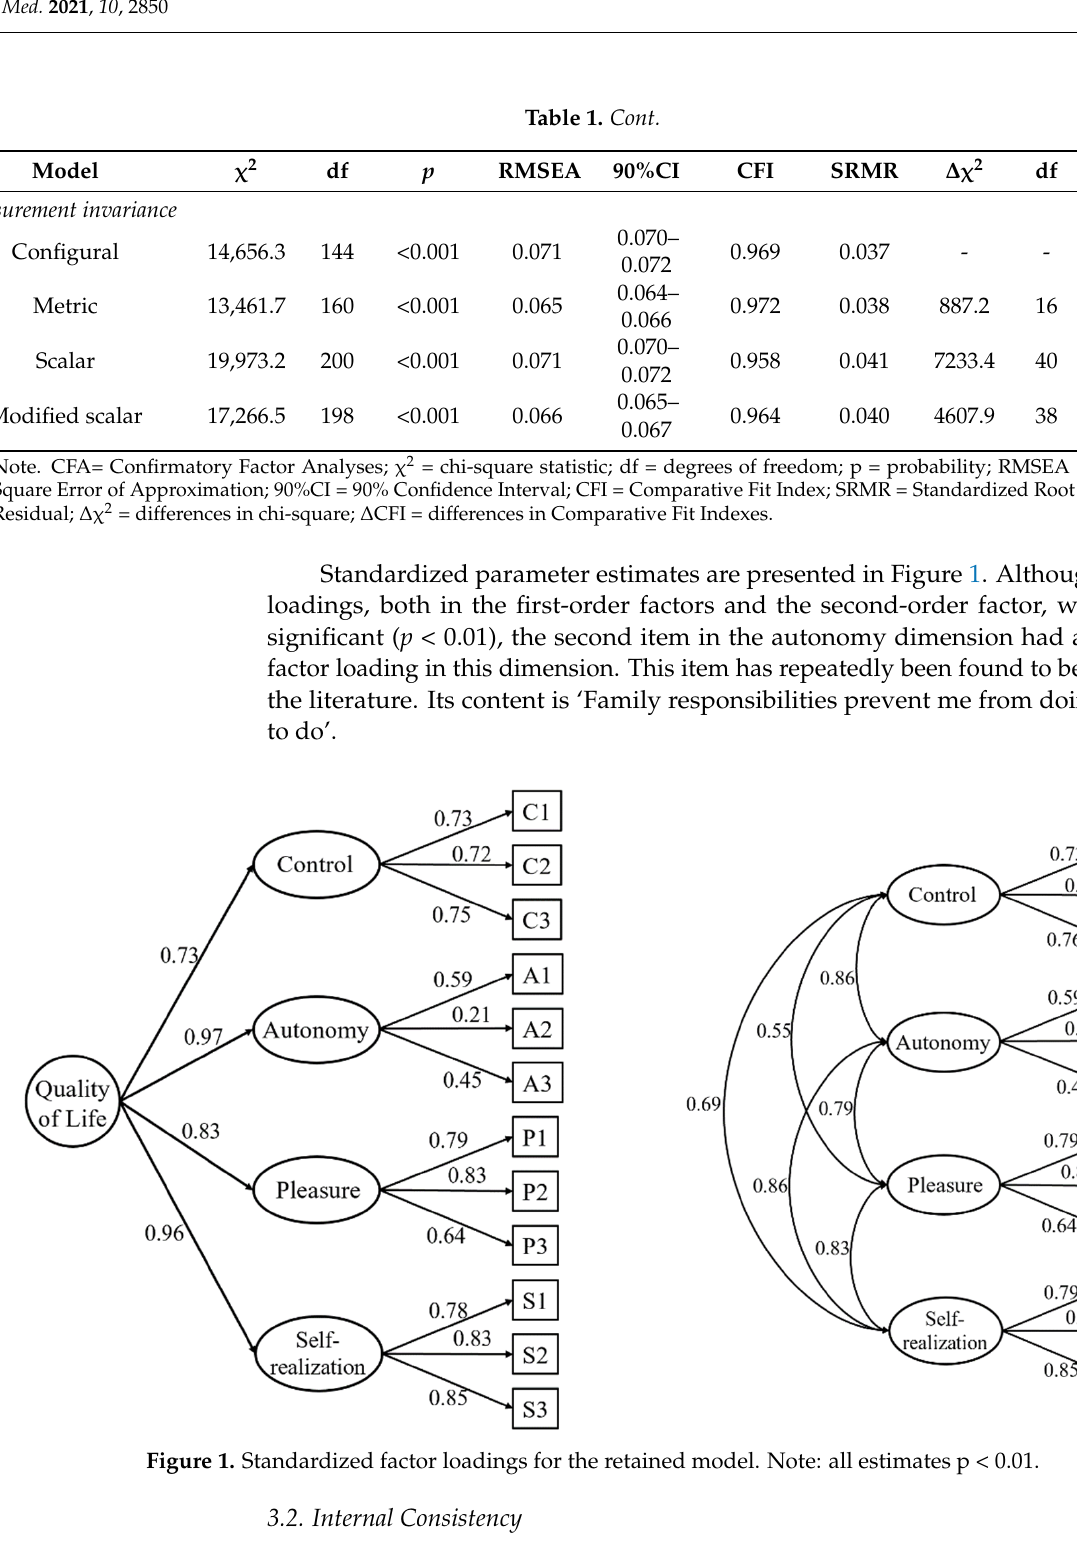
Table 2. Means, standard deviations (SD), and corrected item-total correlations ( r it ) for the 12 items in the CASP measure (Control, Autonomy, Self-realization and Pleasure). Item